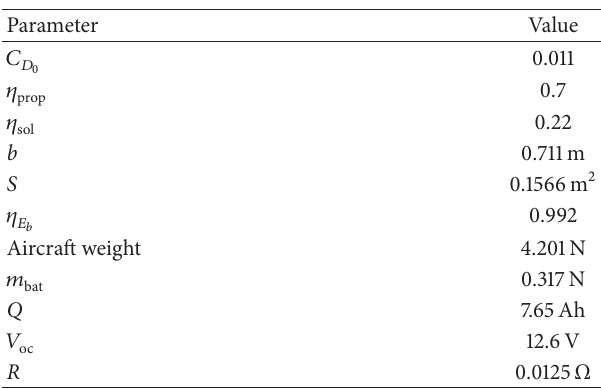
Table 1: UAV model